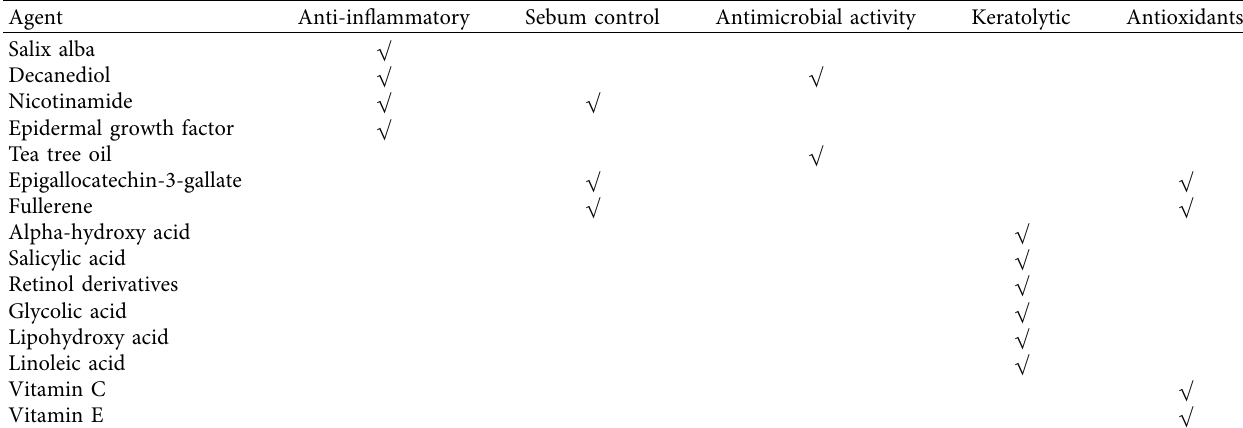
Table 1: Dermocosmetic Ingredients targeting pathogenic pathways of Acne [18].